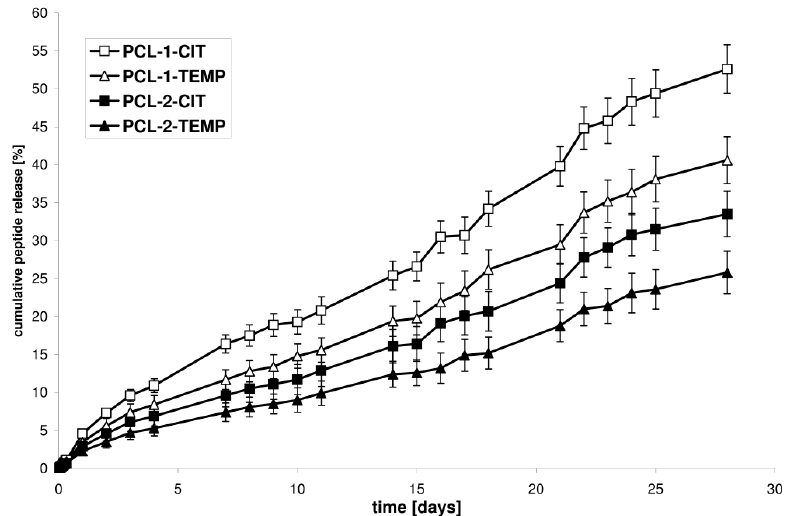
Figure 3. Cumulative release of peptides from PCL-1-CIT, PCL-1-TEMP, PCL-2-CIT, and PCL-2-TEMP over 28 days (each point represents mean ± SD of three points).